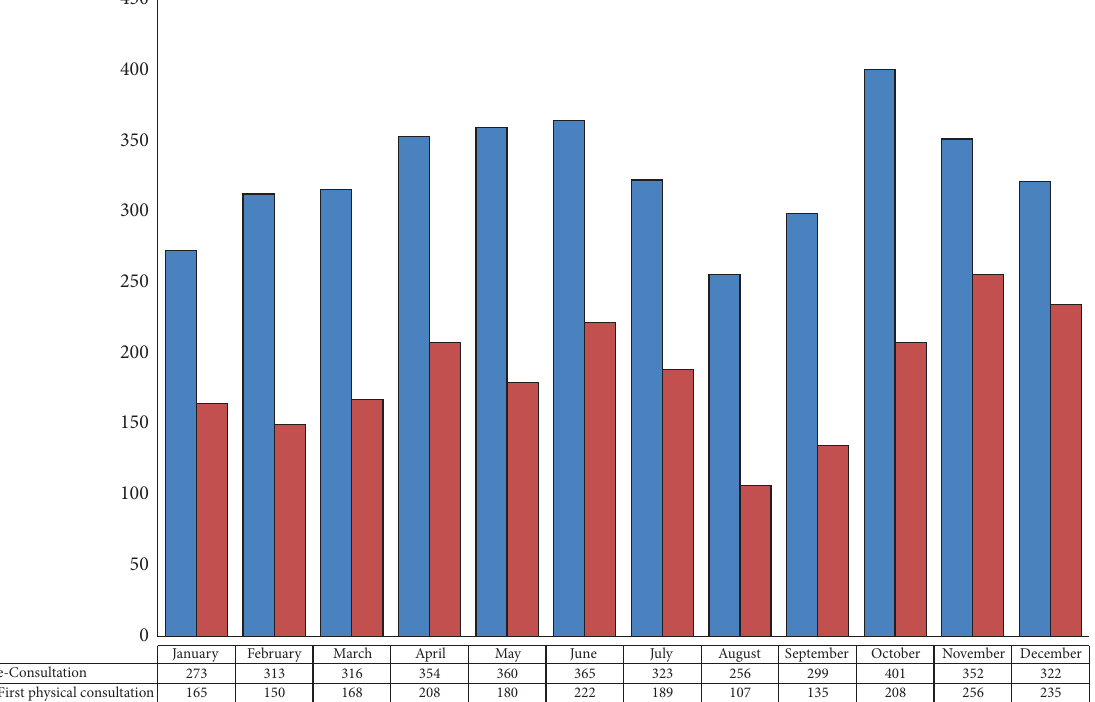
Figure 3: Monthly number of e-consultations and frst face-to-face consultations in 2021. Table 1: Clinical-epidemiological characteristics of patients in the preintervention (2019) and the postintervention (2021)